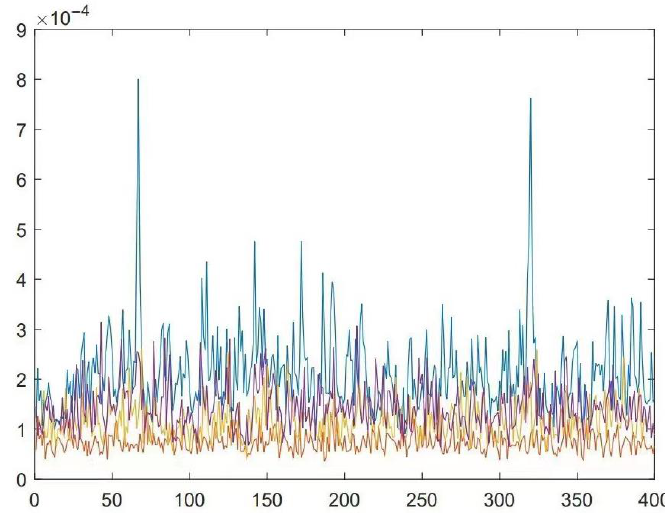
Figure 1. Estimation process of the parameter σ 2 .